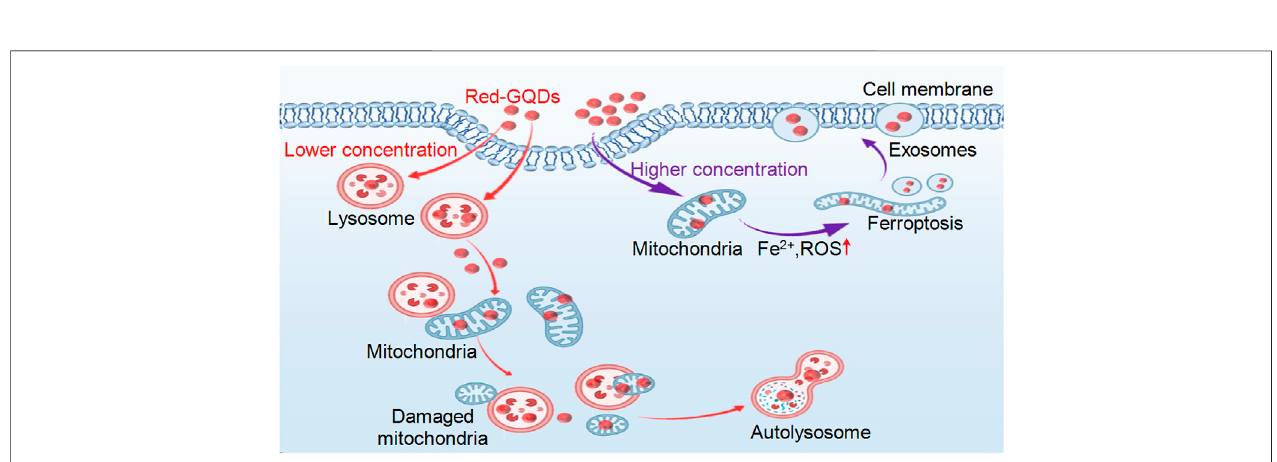
FIGURE 6 | Schematic illustration of Red-GQDs distribution and biological function in living HeLa cells.